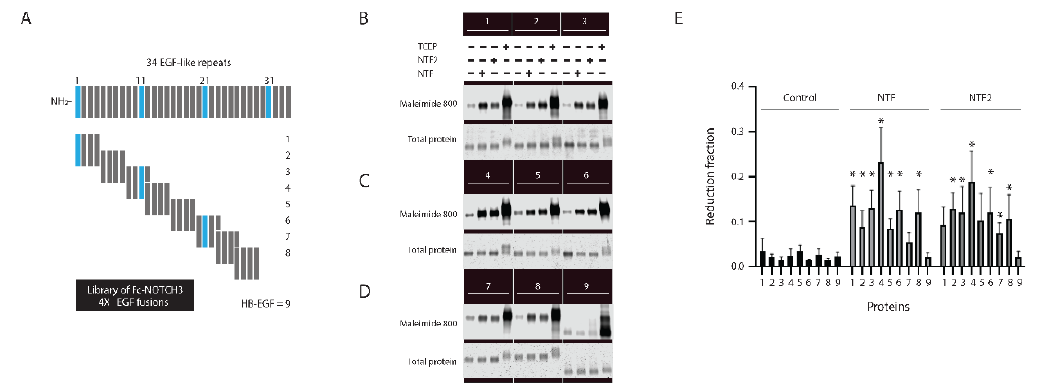
Figure 2. Trans-reduction of the four EGF domain fragments of NOTCH3 by NTF or NTF2. ( A ) The schematic representation of the thirty-four EGF repeats present in NOTCH3 is shown on top; below we show a map of each purified protein preparation aligned to NOTCH3; fragments 1–8 each contain Fc fused to four EGF domains. HB-EGF (fragment 9; fused to the C-terminus of Fc) is a non-NOTCH3 EGF domain-containing protein used as a negative control. ( B – D ) Each EGF fragment (200 ng) was treated with either 2 µ g NTF, NTF2 or 2.5 mM TCEP and the reduced protein was labeled by maleimide dye followed by detection of available cysteines by gel scanning (upper panel). Protein loading was controlled by Simply Blue staining detected by gel scanning (lower panel). ( E ) Reduction fraction (ratio of maleimide signal to Simply Blue signal, which was then normalized to the ratio after TCEP treatment) for control, NTF, and NTF2 treatments for each protein is shown in the plot (for NTF treatment, fragments 1, 2, 3, 4, 5, 6, and 8 show differences compared to control, and for NTF2 treatment, fragments 2, 3, 4, 6, 7, and 8 show differences compared to control, * p < 0.05). Reduction fractions after exposure to NTF and NTF2 was compared by subtracting the value achieved by NTF from that by NTF2 (normalized by control/TCEP values) and available in Supplemental Figure S1. Reaction volumes were 5 µ L followed by addition of 10 µ L labeling mix. All experiments were performed at least four times and included in the final quantified